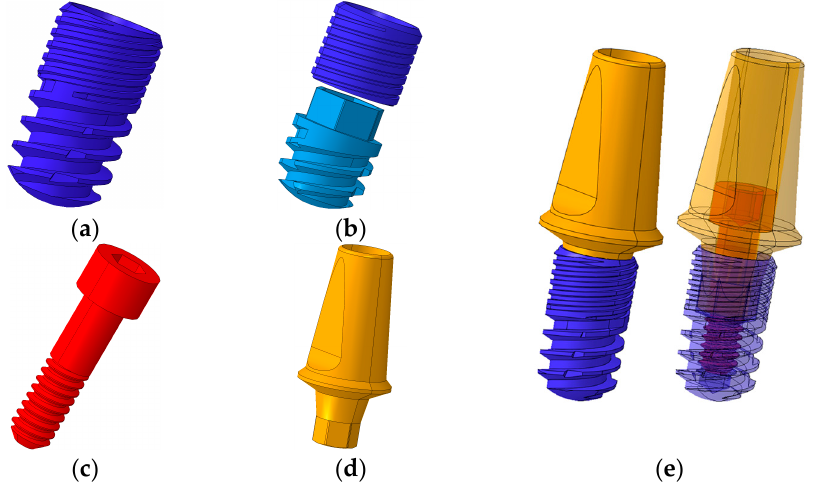
Figure 1. 3D CAD model of dental implant system. ( a ) Conventional fixture type, ( b ) separable fixture type, ( c ) abutment screw, ( d ) abutment, and ( e ) assembled model of implant system (Left: exterior design of the fixture/Right: internal structure of the fixture).